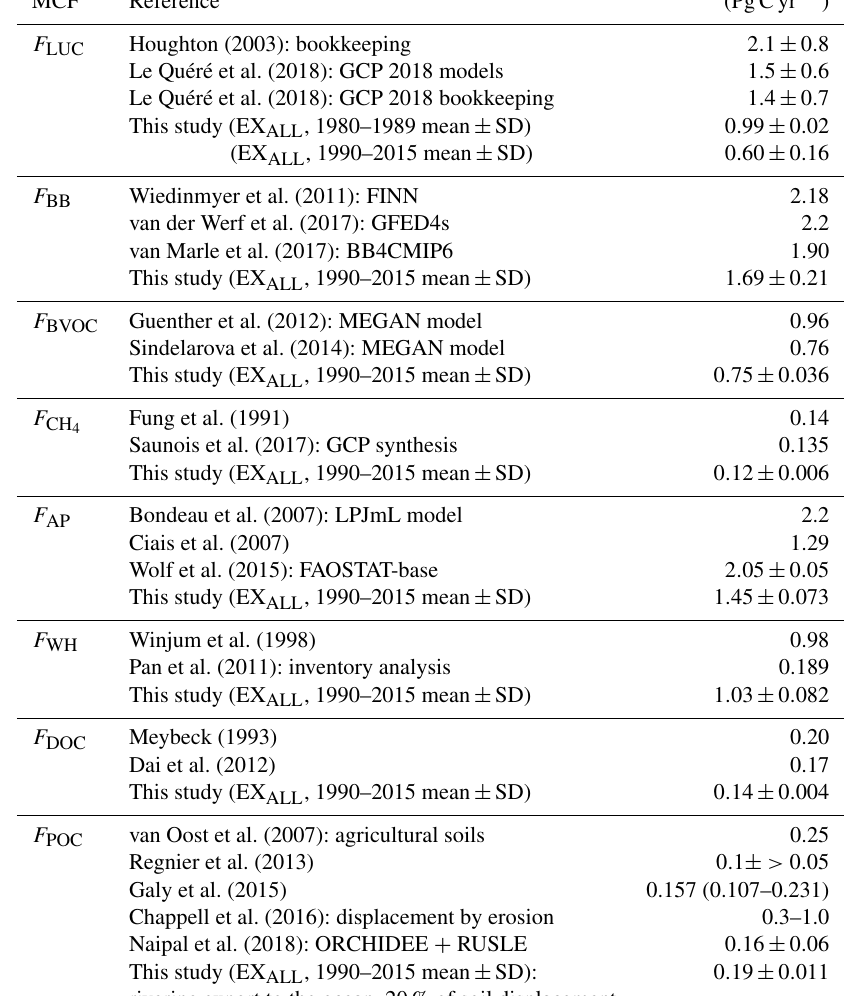
Table 2. Summary of previous estimates of minor carbon flows